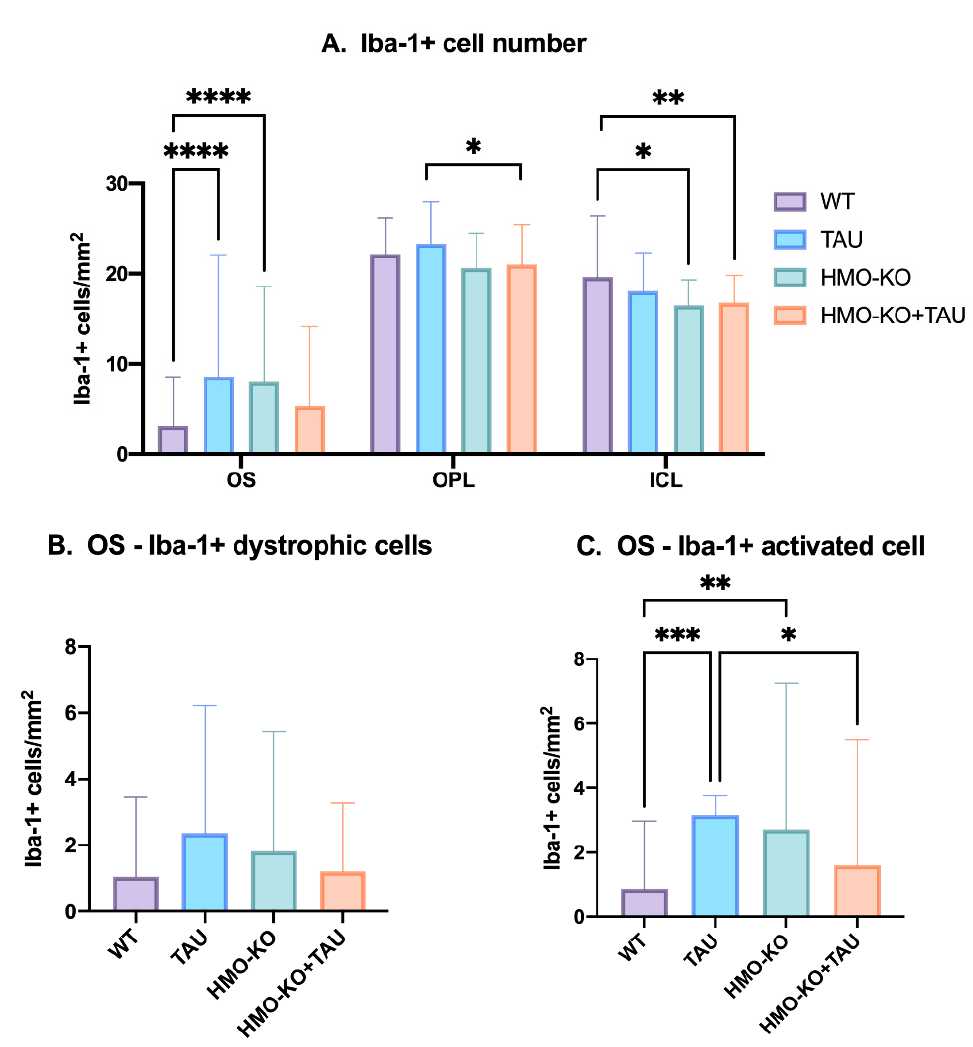
Figure 5. Microglial cell numbers. ( A ) Number of Iba-1+ microglial cells per retinal area of 0.1502 mm 2 in the different retinal layers in each of the study groups; two-way ANOVA. ( B ) Number of dystrophic Iba-1+ cells in OS layer in the different study groups; one-way ANOVA. ( C ) Number of activated Iba-1+ cells in OS layer in the different study groups; one-way ANOVA. All data are expressed as mean value ( ± SD). * p < 0.05, ** p < 0.01, *** p < 0.001, **** p < 0.0001. Number of retinas used in the experiment: WT n = 6, HMO-KO n = 6, TAU n = 6, and HMO-KO+TAU n = 6. Number of Dystrophic Iba-1+ Microglia and Iba-1+ Microglia Activated in OS Layer In the OS layer, there was a non-significant increase of dystrophic microglia in the TAU group with respect to the WT group ( p > 0.05). Additionally, a non-significant decrease was found in the HMO-KO+TAU group with respect to the TAU group (Figure 5B).